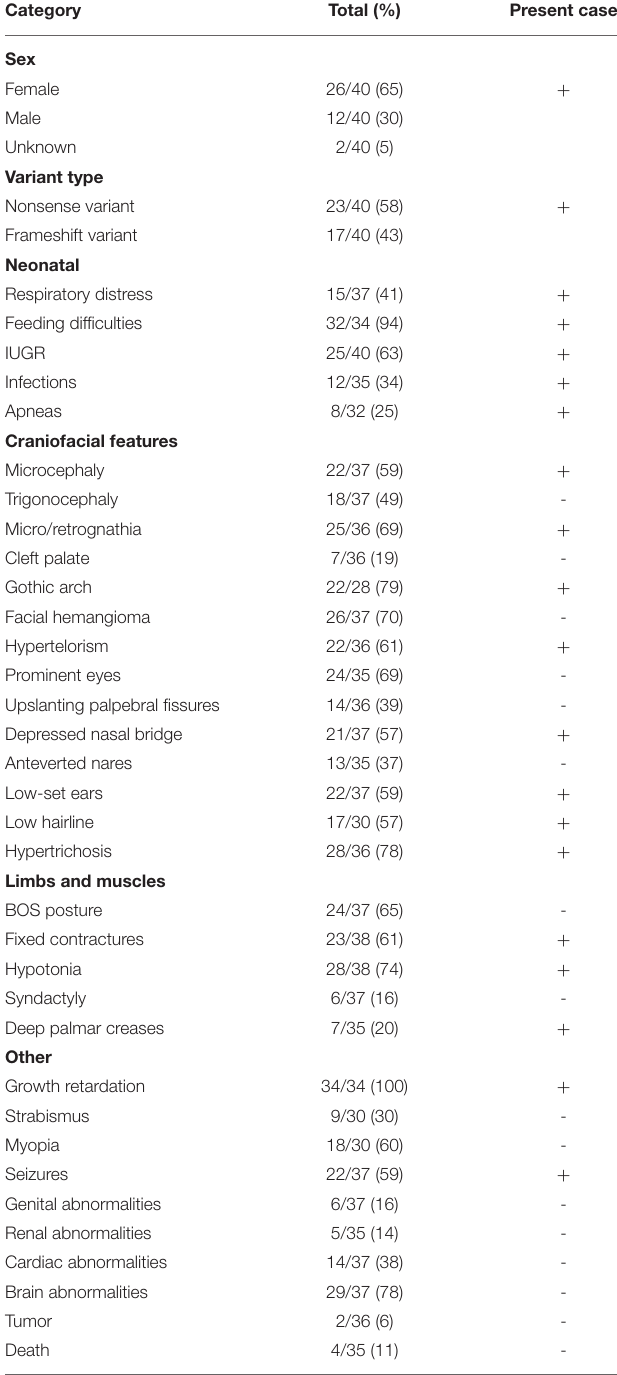
TABLE 1 | Prevalence of clinical characteristics associated with ASXL1 variants in patients diagnosed with BOS. Category Total (%) Present case consent from the proband’s guardian, exome sequencing